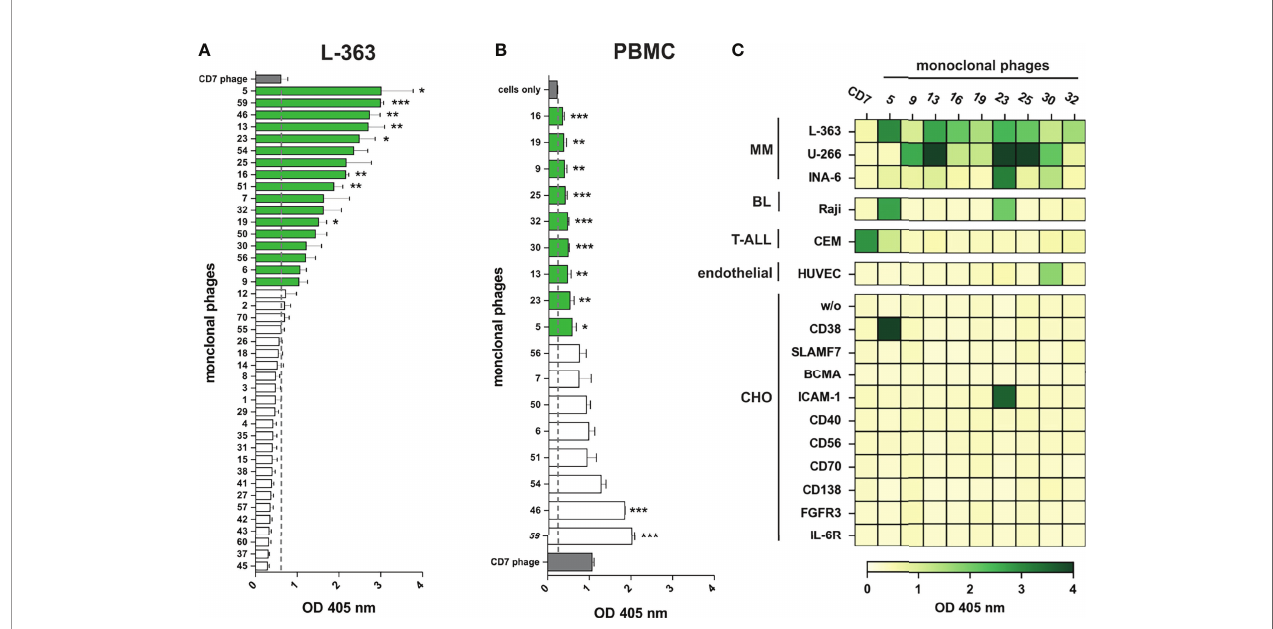
FIGURE 3 | Binding analyses of monoclonal phage antibodies. (A) 1 x 10 6 L ‐ 363 myeloma cells were incubated with 1 x 10 9 colony-forming-units (CFU) from the 41 different VH clonotypes and tested in ELISA experiments. Cell surface bound phages were detected using anti-M13-HRP antibody and absorbance was measured at 405 nm. 17 phages (green) showed a signal above the one obtained for CD7-speci fi c phage (grey; dotted line), which was used as negative control. (B) Results of ELISA experiments performed equally with 1 x 10 6 PBMC from healthy donors are shown. 9 phage antibodies (green) bind low to moderate to PBMC (green) compared to cells alone (grey; dotted line). CD7-speci fi c phage (grey) showed antigen-dependent binding to T cells and NK cells and served as positive control in these experiments. Mean values ± SEM of three independent experiments are shown for these ELISA experiments. *p ≤ 0.05, **p ≤ 0.01, ***p ≤ 0.001 monoclonal phage vs. control. (C) The 9 most promising candidates were further tested in whole cell ELISA experiments with plasma cell lines (MM) L-363, U ‐ 266, and INA-6, Raji Burkitt ’ s lymphoma (BL) cell line, T cell acute lymphoblastic leukemia cell line (T-ALL) CEM, human endothelial cells (endothelial) from healthy donors (HUVEC) and stable transfected CHO cells expressing either CD38, SLAMF7, BCMA, ICAM-1, CD40, CD56, CD70, CD138, FGFR3 or IL-6R. Color bar was set OD 405 nm = 0 (white) to OD 405 nm > 4 (dark